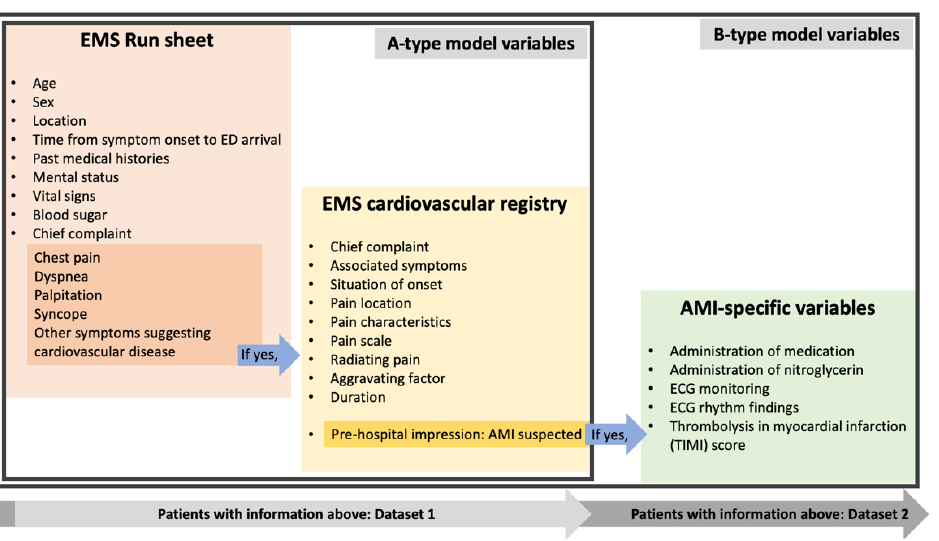
Figure 1. Flow chart for the derivation of datasets (EMS: emergency medical service; ED: emergency department; AMI: acute myocardial infarction; ECG: electrocardiogram).